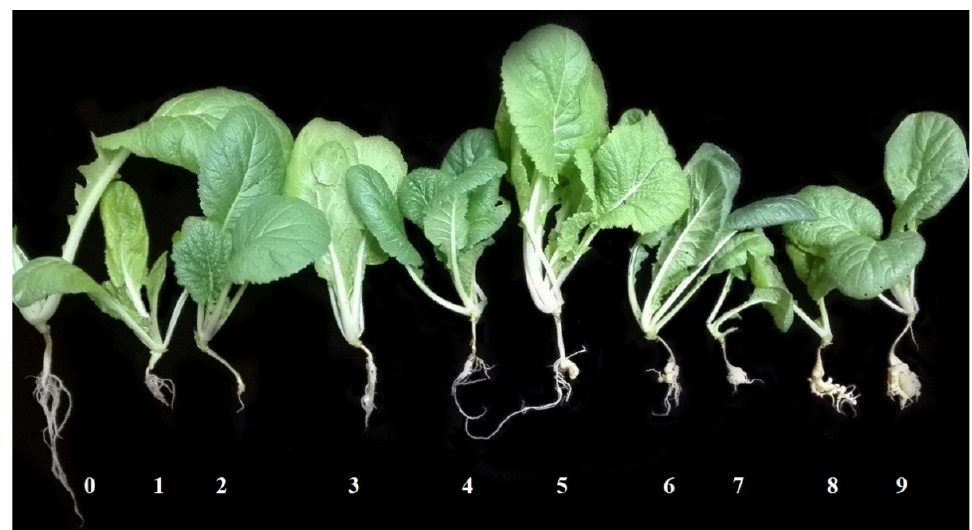
Figure 1. Disease rating scale ranges of clubroot symptoms on plant roots in F 2 population. Scale is from 0 to 9, where 0 = no infection (no symptoms) and 9 = heavily infected (severe galling).